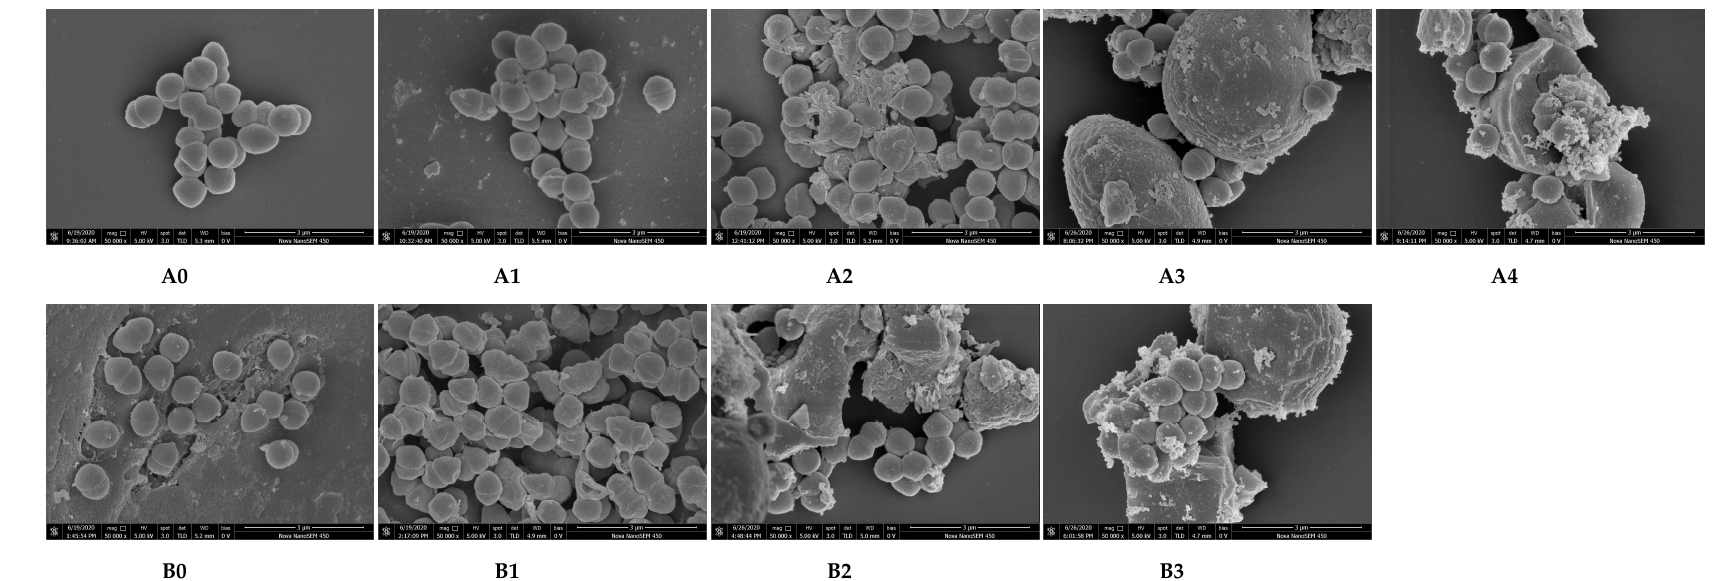
Figure 5. SEM images of E. faecium inoculated in wheat samples with three physical structures (all images were 50,000 × magnification). ( A0 ) was the liquid suspension of E. faecium without any treatment. ( A1 , A3 , B0 , B2 ) were control cell samples without heating when inoculated in wheat kernel surface (a w = 0.66), wheat flour, wheat kernel surface (a w = 0.99), and wheat dough, respectively. ( A2 , A4 ) were treatment samples inoculated in wheat kernel surface (a w = 0.66) and wheat flour heated at 80 °C for 5 min in HBS. ( B1 , B3 ) were treatment samples inoculated in wheat kernel surface (a w = 0.99) and wheat dough heated at 62 °C for 5 min in HBS.